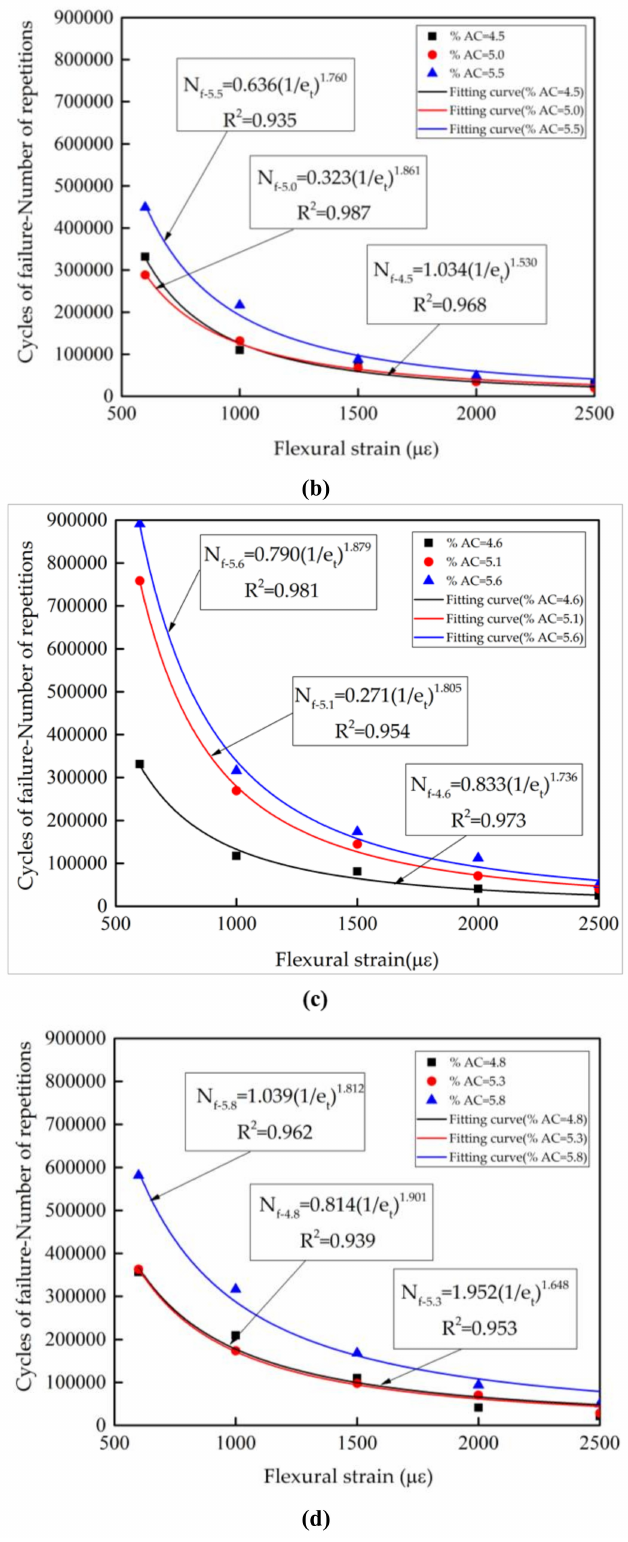
Figure 5. Relationship between flexural strain and fatigue life (%AC is asphalt content in figure). ( a ) Without fiber; ( b ) 0.15% fiber content; ( c ) 0.30% fiber content; and ( d ) 0.45% fiber